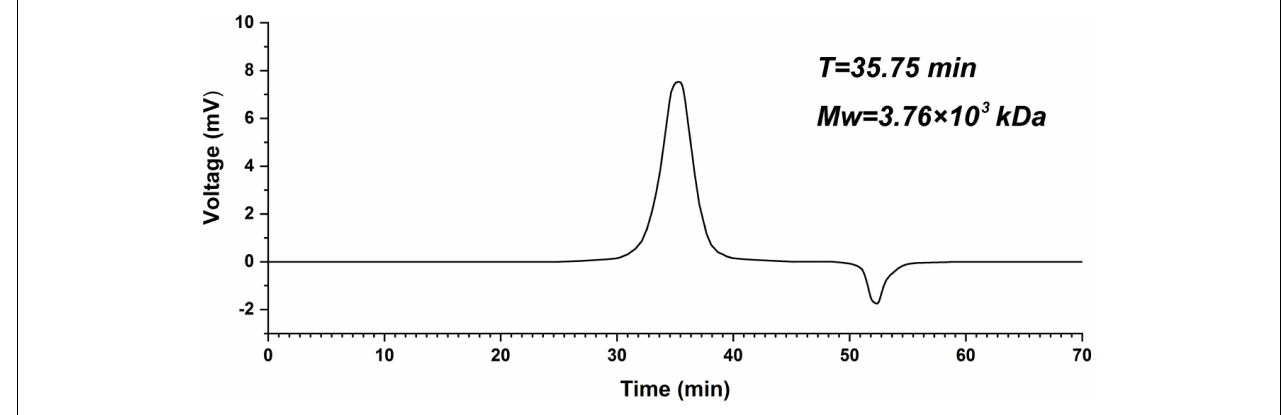
FIGURE 2 | High-performance gel-permeation chromatography chromatogram of polysaccharide K-CMLP.